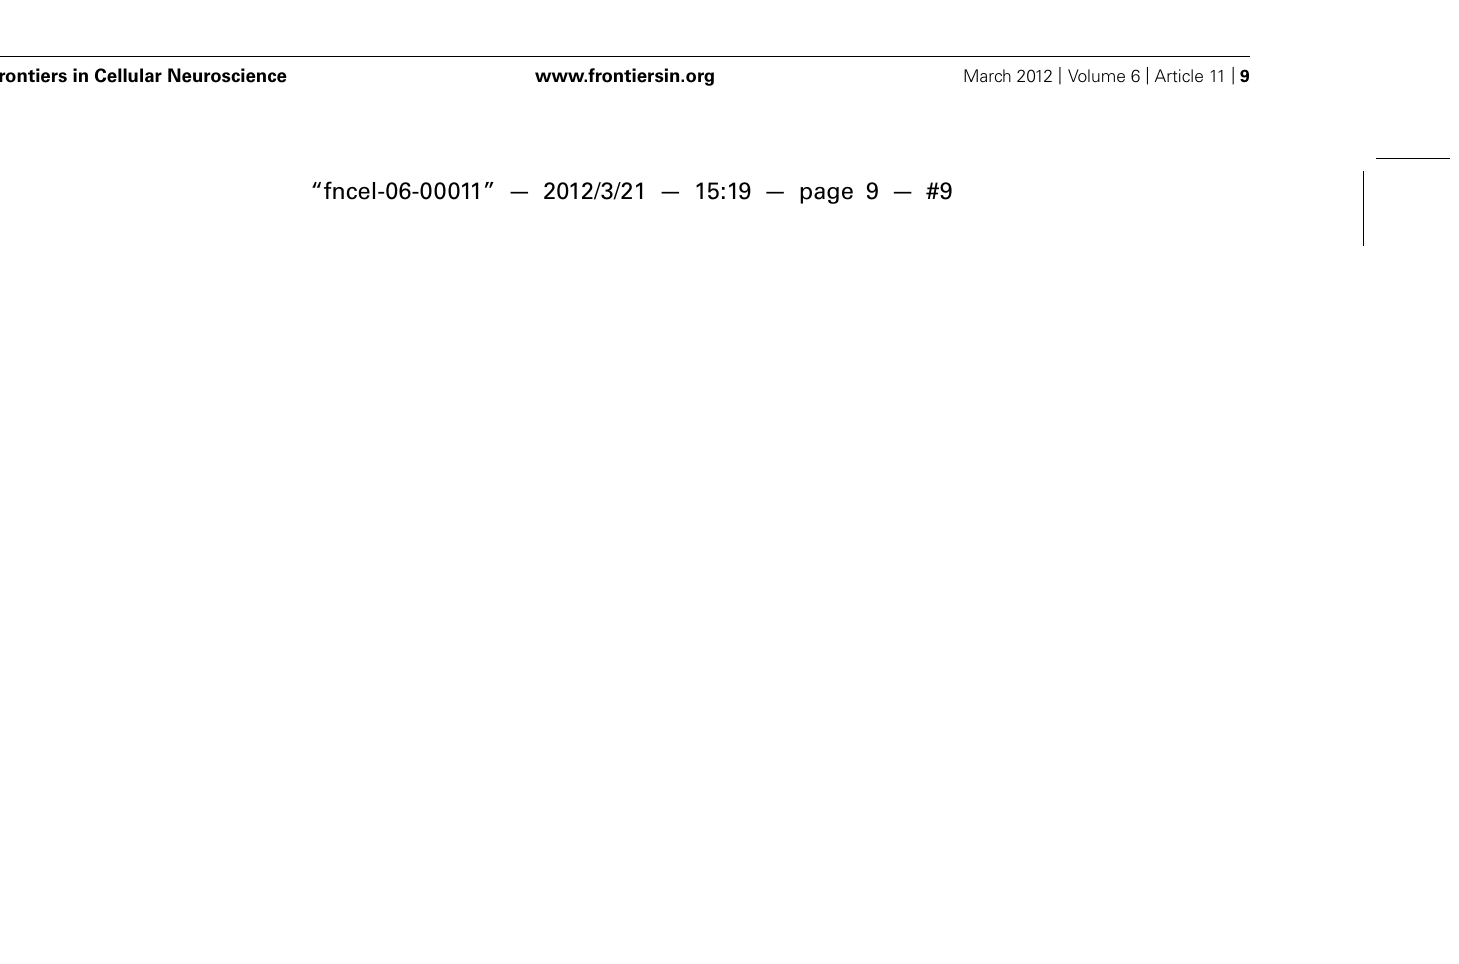
FIGURE 6 | Chromogenic detection of GFP shows extensive axonal growth of grafted neurons 10 weeks after transplantation. Darkfield photo-montages of immunohistochemistry for GFP shows robust, long- distance outgrowth throughout the host brain. Coronal (i–vi) , horizontal (vii–ix) , and parasagittal (x) sections illustrate extensive GFP + growth throughout the rostro-caudal and medio-lateral planes, particularly along host white matter tracts including: a prominent outgrowth anterior to the